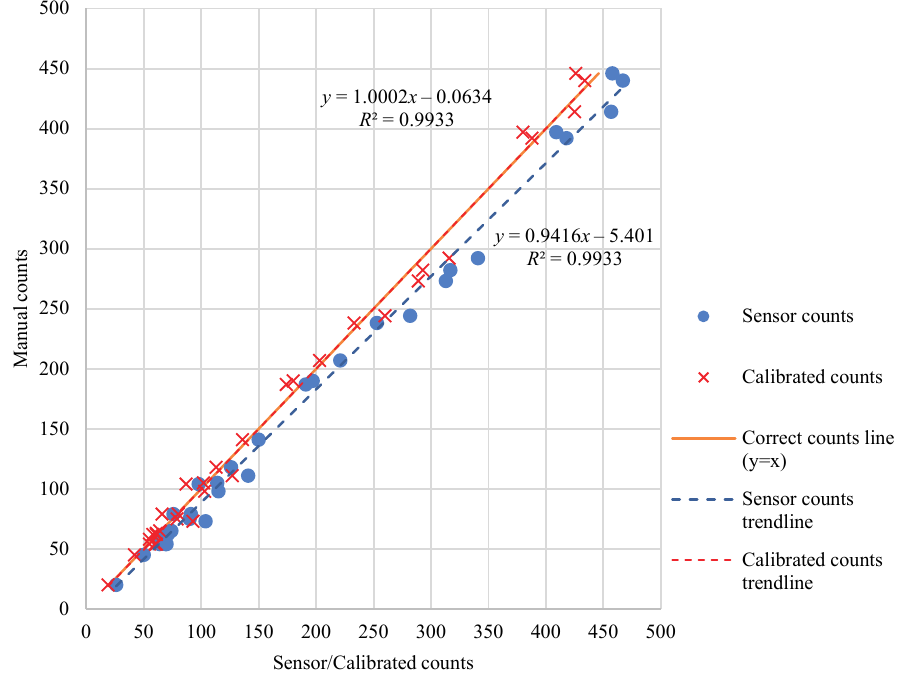
Fig. 3. Manual, pyroelectric and calibrated counts before and after hourly observation calibration. The results of calibration show that the calibration formula successfully reduced errors in 82 % of measurements. As the manual counts increases, the calibration error size increases, but more importantly, the calibration error rate decreases. This means that greater accuracy is achieved through the proposed